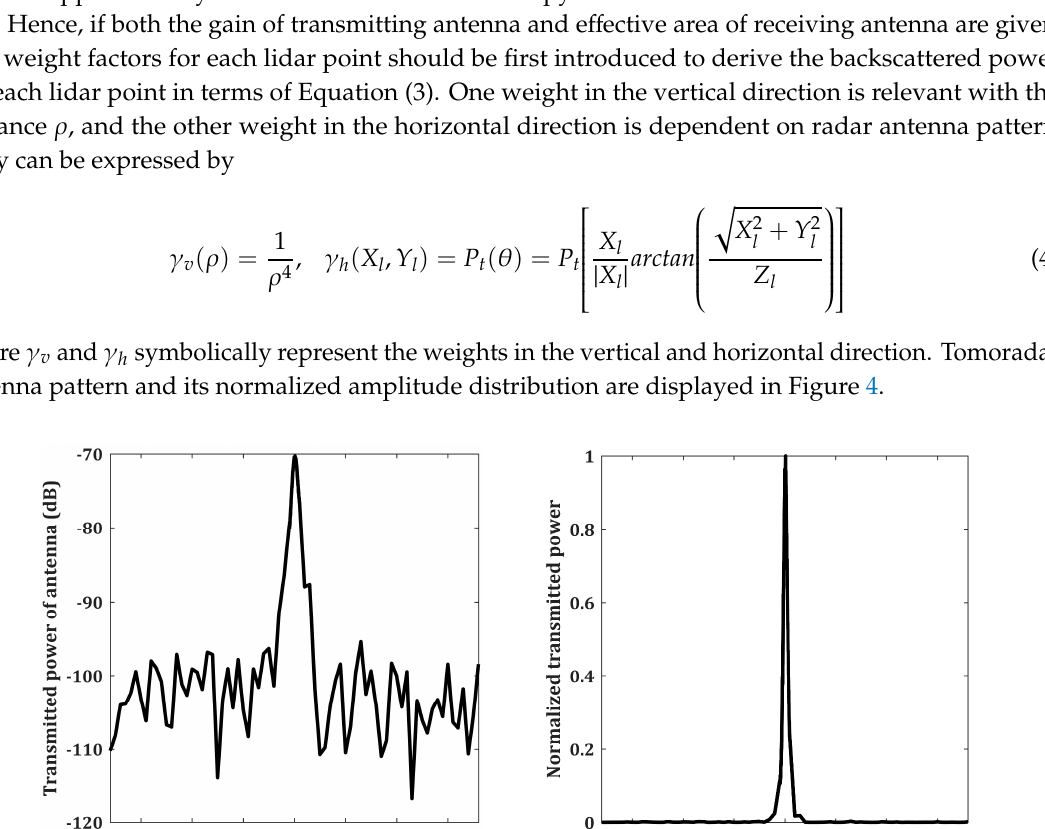
. The zero max ( 10 PdB /10 )